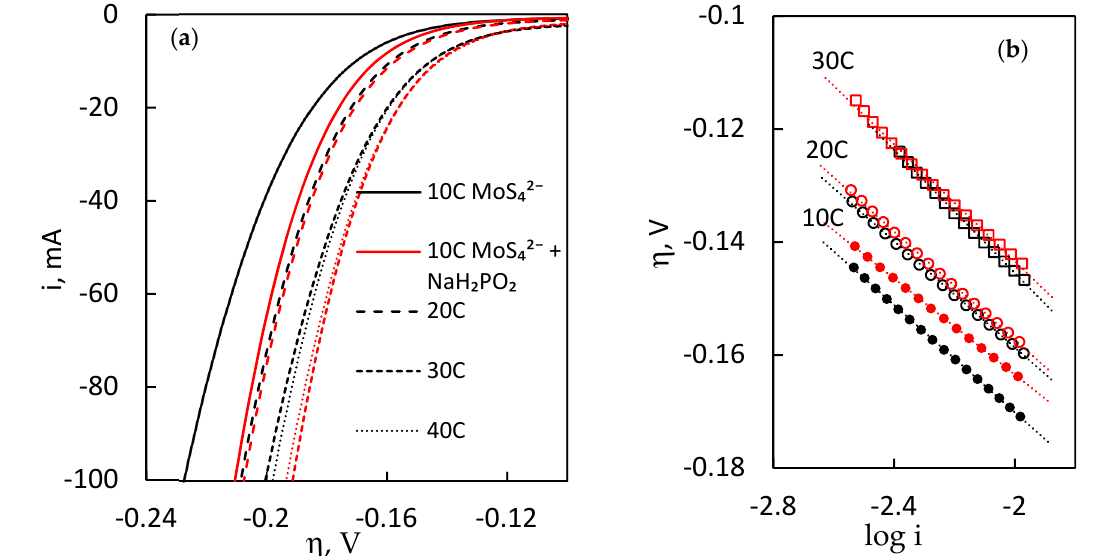
Figure 4. ( a ) iR-corrected polarisation curves of electrodeposited MoS 2 films in 0.5 M H 2 SO 4 ; and ( b ) Tafel slopes of the respective films, with scan rate − 2 mV s − 1 . (Red lines correspond to samples, deposited with NaH 2 PO 2 ). Table 2. Electrocatalytic activity parameters of the electrodeposited MoS 2 films from electrolytes containing MoS 4 2 − , and MoS 4 2 − + NaH 2 PO 2 (denoted with *). Q, C.